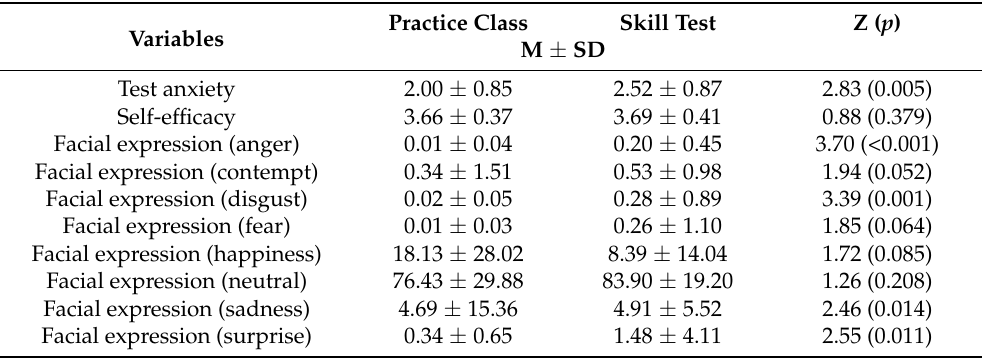
Table 1. Comparison of test anxiety, academic efficacy, and facial expression between practice class and skill test ( n = 33).